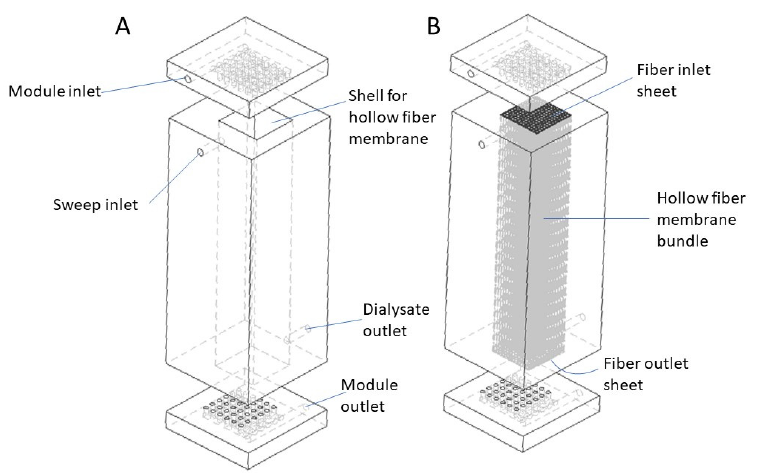
Figure 3. ( A ) Schematic diagram of the cuboid shell and the flow distribution and collection plates of the proposed cuboid hemodialyzer. ( B ) Proposed cuboid hemodialyzer with hollow fiber membrane in place.